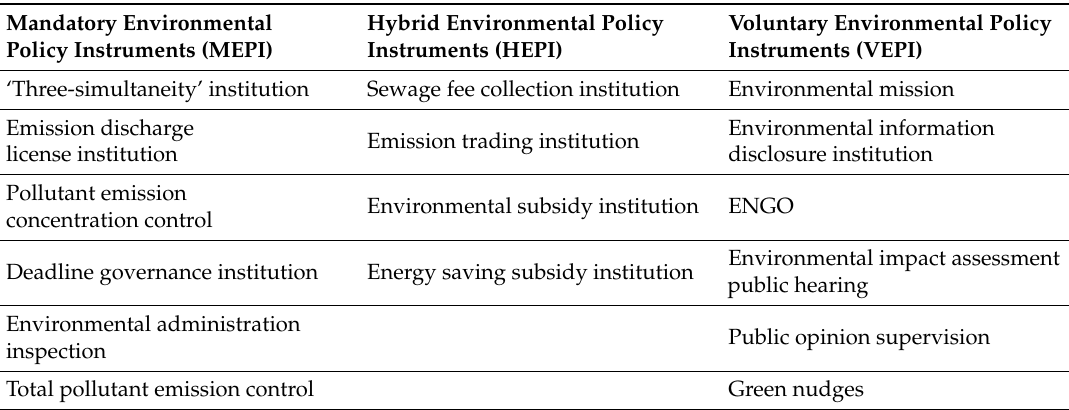
Table 2. The environmental policy instruments commonly used in